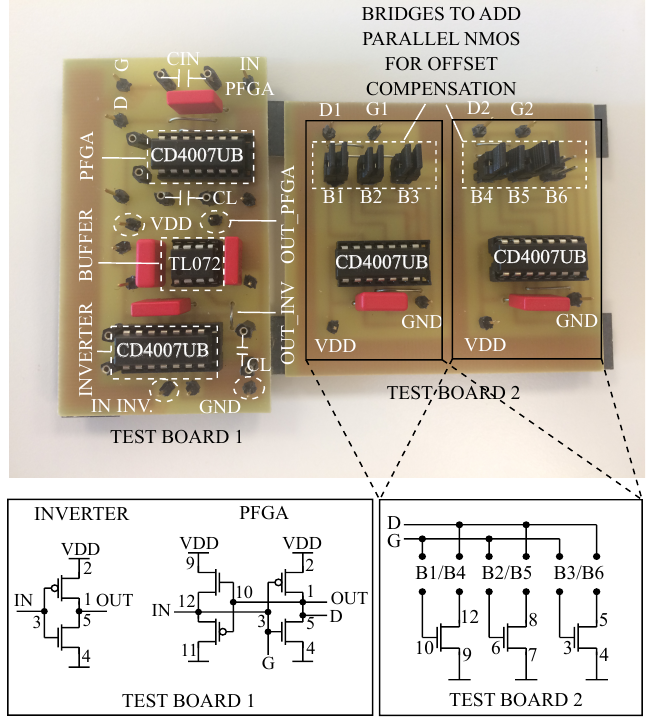
Figure 16. Prototype of a LL-PFGA (low leakage PFGA) used for tests and